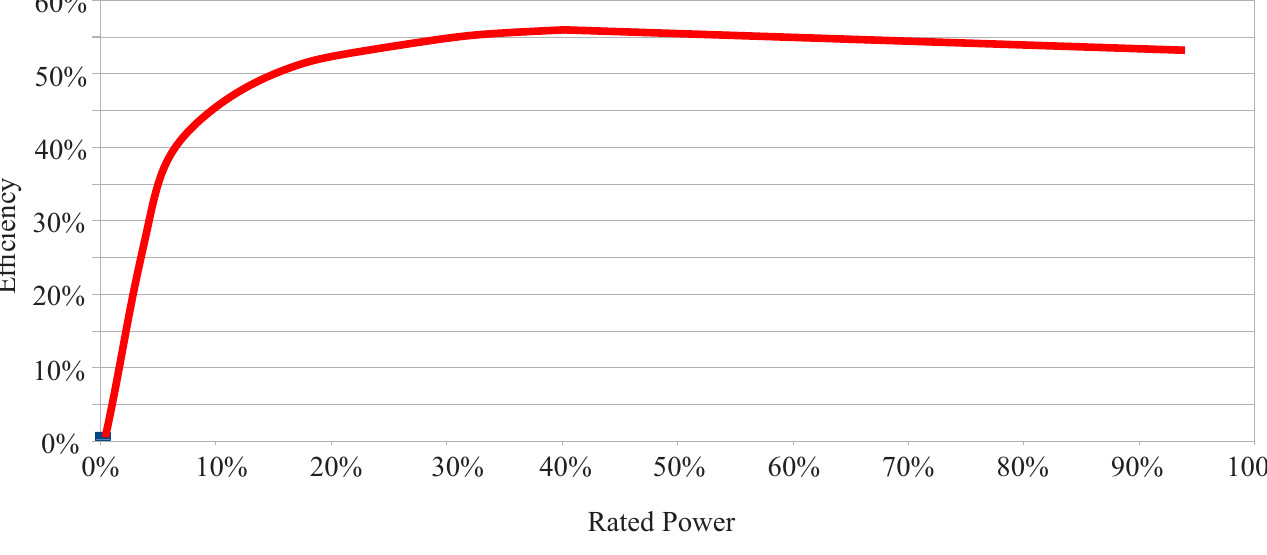
Figure 5. Efficiency curve of the PEMFC used in this work. The efficiency curve is drawn based on the profile found in [56] and on the values found in